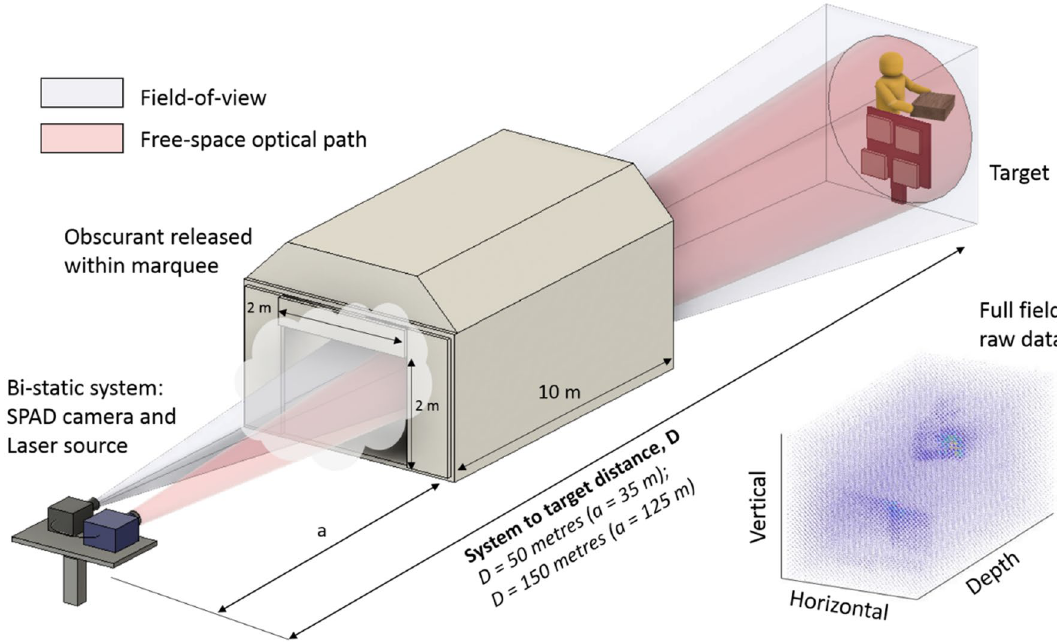
Figure 1. Measurement set-up for the bistatic time-of-flight depth imaging system comprising a 32 × 32 format InGaAs/InP SPAD detector array and a pulsed fibre laser source. The time-of-flight approach was used to obtain depth information of targets at ranges of 50 and 150 m from the transceiver location, through various densities of an oil-based vapour (contained inside a 10-m-long marquee). The marquee was positioned at distances of approximately 35 m and 125 m from the LiDAR system for the for 50 m and 150 m ranges, respectively. An example of a raw data cube representing detected photon counts is also shown. The data was obtained by imaging a moving man located behind fixed boards through an obscurant. The raw data shown was acquired for 100 ms, which is composed of 15,000 binary frames. During the indoor 50 m measurements the fog dispersed backwards and enveloped the target